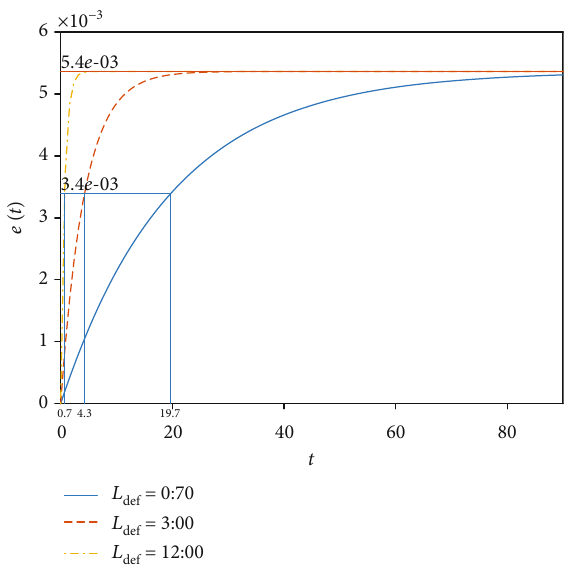
Figure 6: Viscoelastic-creep behaviors, e ð t Þ , under di ff erent values j = 0 : 2600 , ϵ = 0 : 2000 , and Δ of L at conditions j (cid:1) ρ def 0 where t ( x -axis) is the time variable and e ð t Þ ( y -axis) is the strain response at time t . The results demonstrate the capability of the PCD equation to control the relaxation time, τ